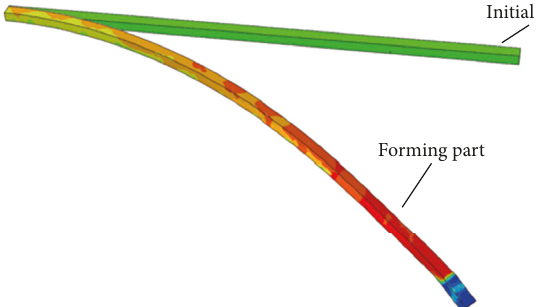
Figure 8: The target shape of the aluminum